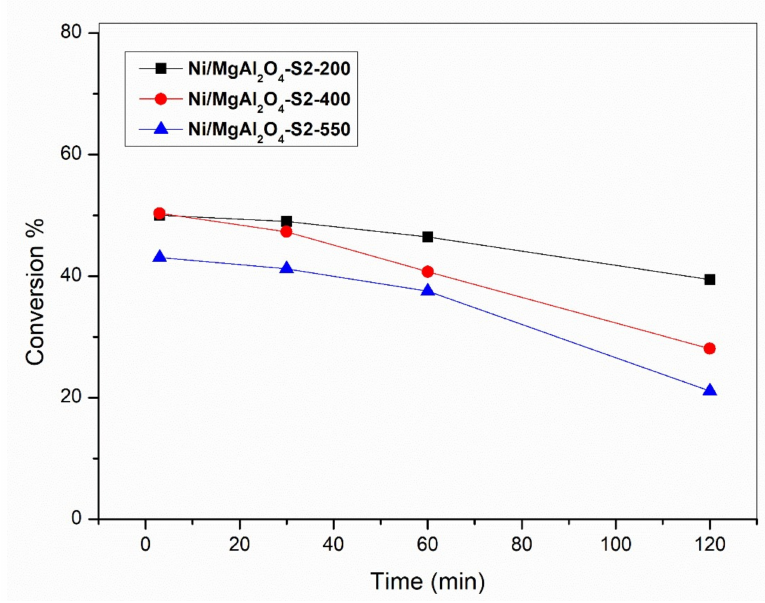
Figure 16. Conversion % of Ni/MgAl 2 O 4 sulfided with (NH 4 ) 2 S at 200 ◦ C (black square), 400 ◦ C (red circle) and 550 ◦ C (blue